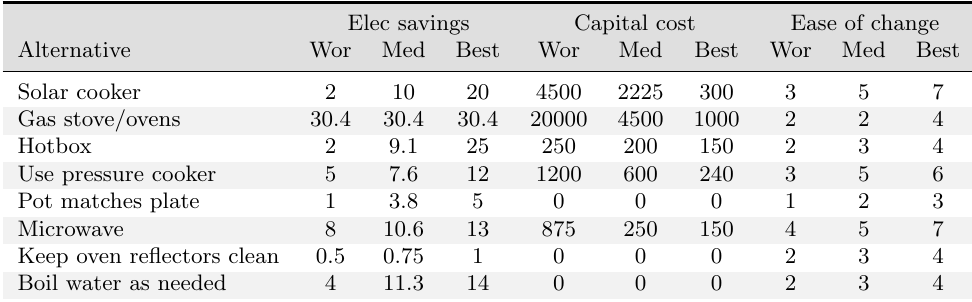
Table 1: Decision table for evaluation of electricity saving